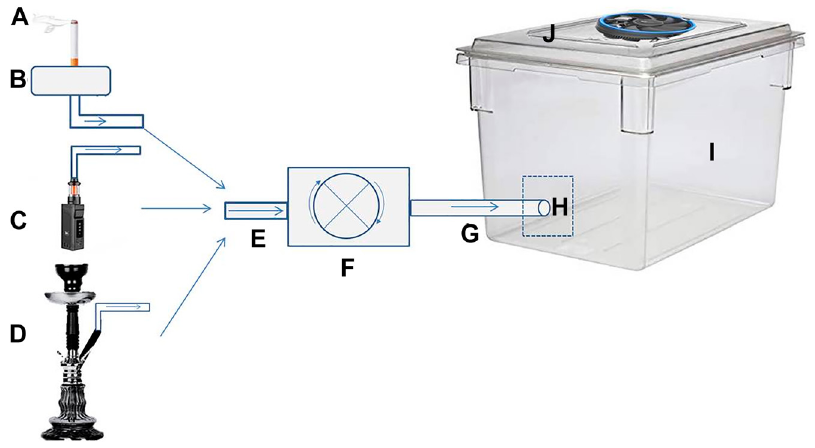
Figure 1: Cabinet settings and the materials used for